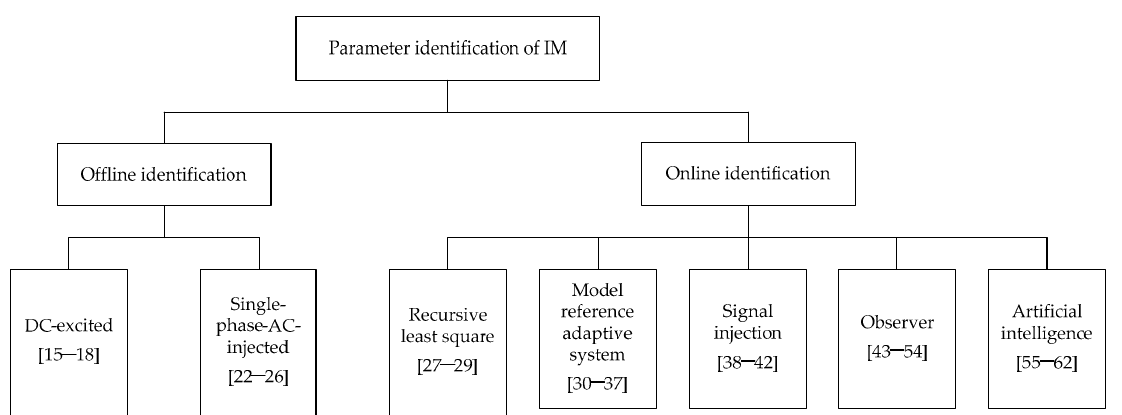
Figure 1. Classification of parameter identification methods for induction motors (IMs).